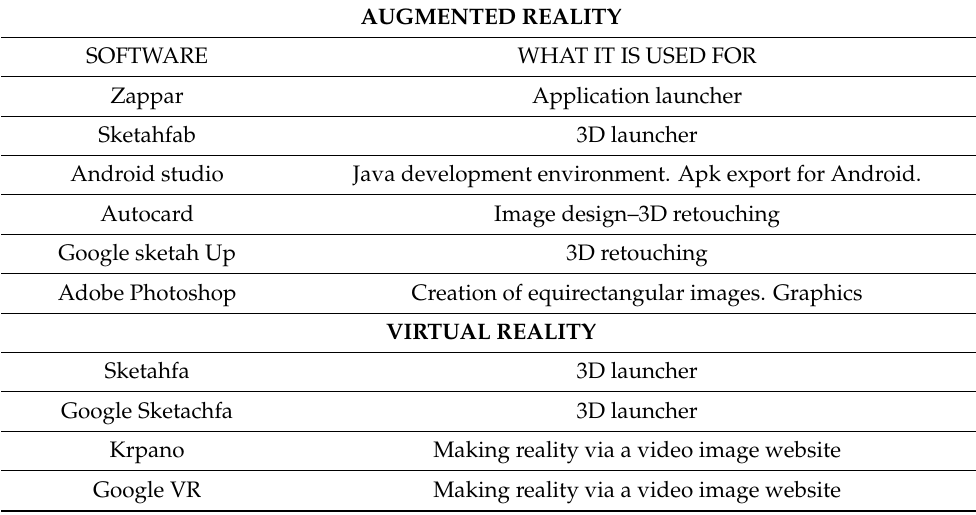
Table 3. Software programs used to produce the MR